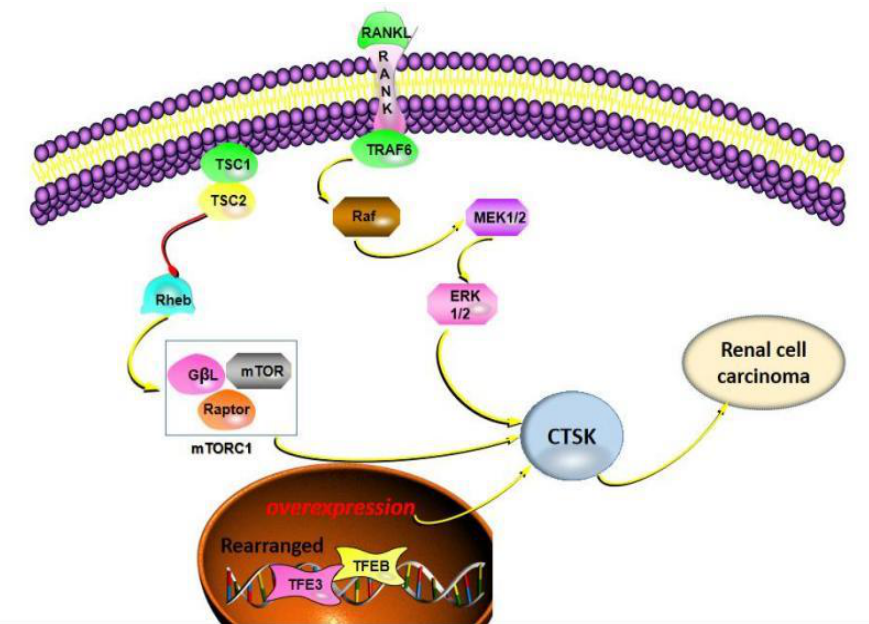
Figure 4. Schematic illustration showing the different mechanisms leading to CTSK expression. Mainly involved in the mTOR signaling pathway, TSC mutations or TFE3 rearrangements or TFEB amplification, which made a vital contribution.